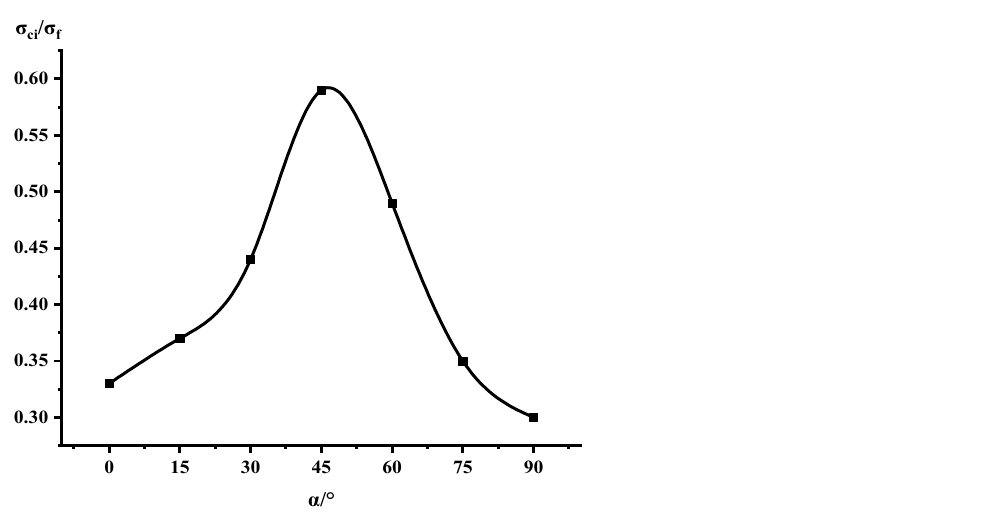
Figure 17. σ ci /σ f Curve with the dip angle of the